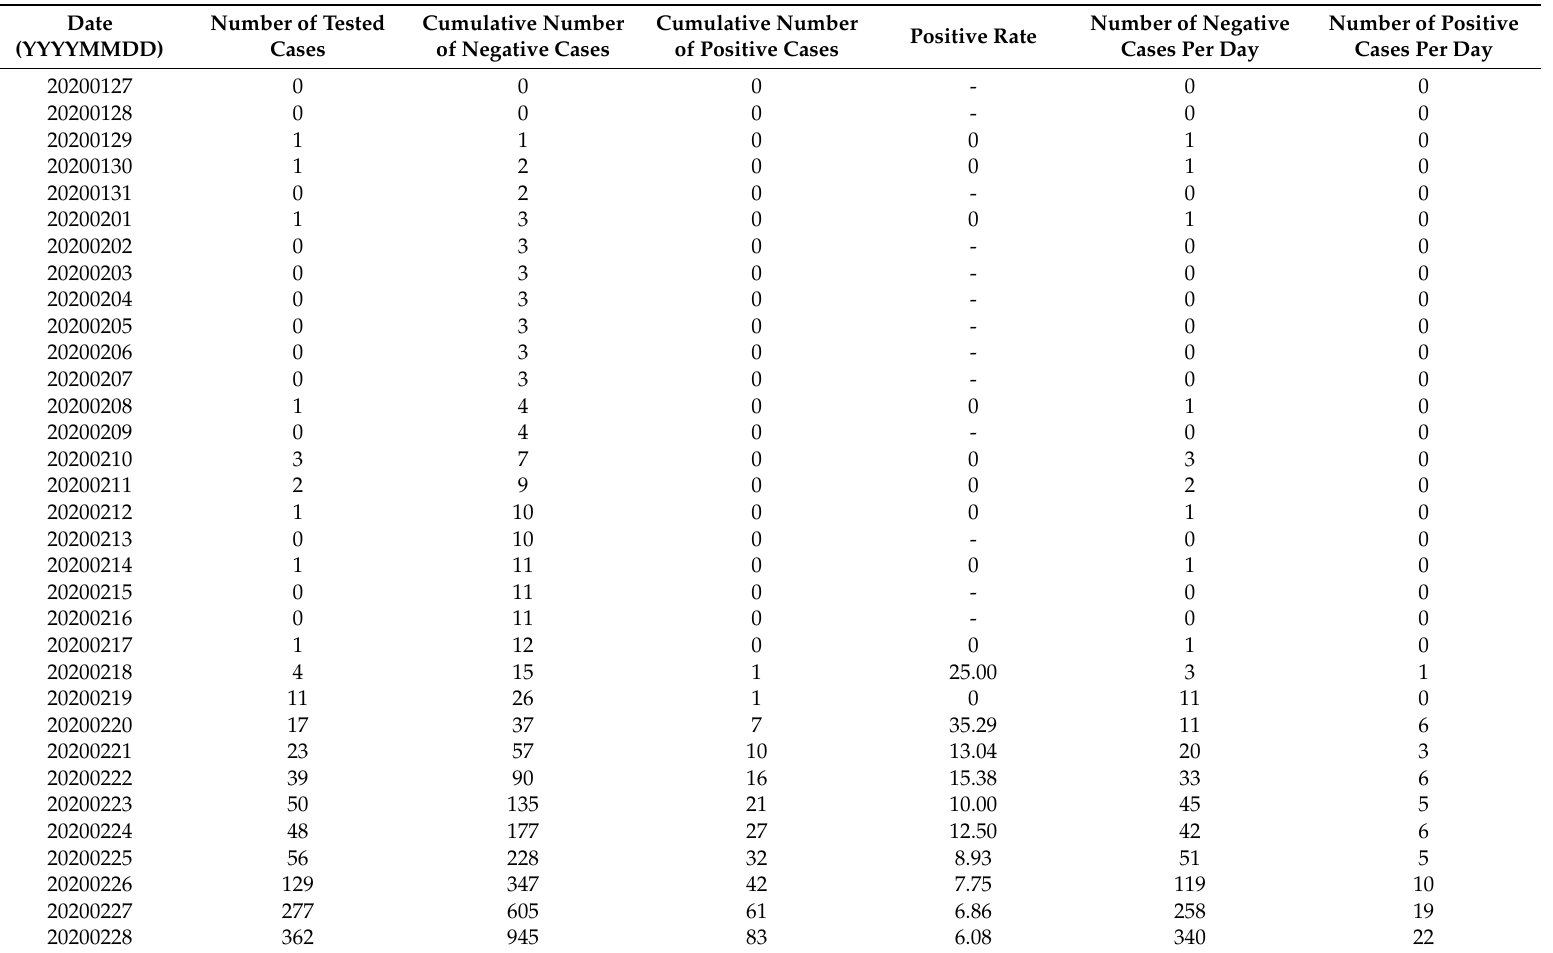
Table 1. A cumulative number of positive and negative severe acute respiratory syndrome coronavirus 2 (SARS-CoV-2) cases and the number of positive and negative cases by date in the screening clinic of our university